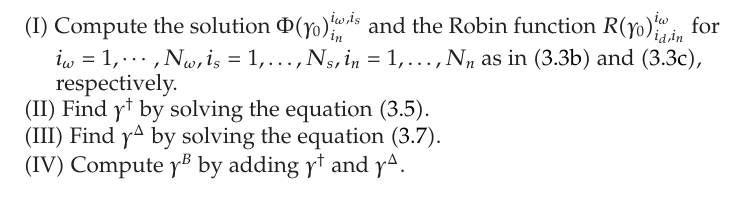
Algorithm 2: Numerical algorithm (cid:6) discretized version (cid:8)